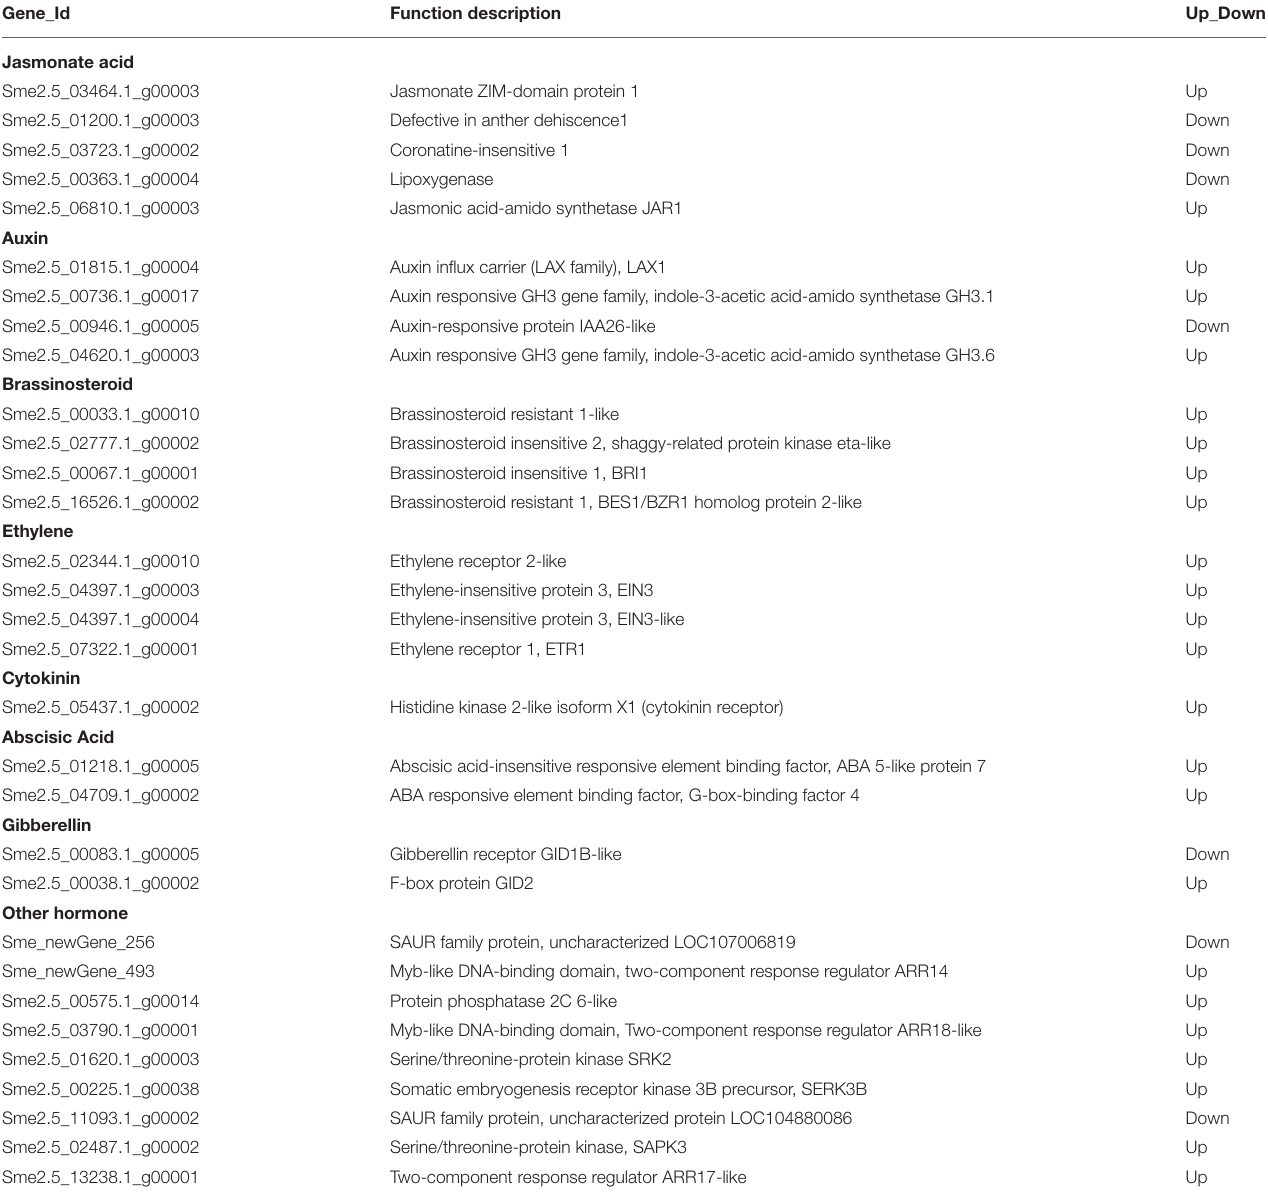
TABLE 2 | Differentially expressed genes (DEGs) involved in hormone signaling pathways. Gene_Id Function